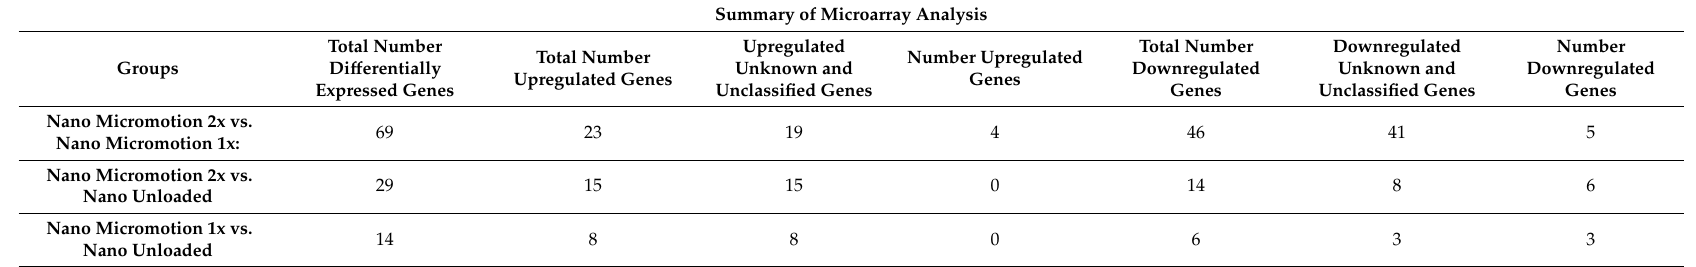
Table 3. Summary of microarray